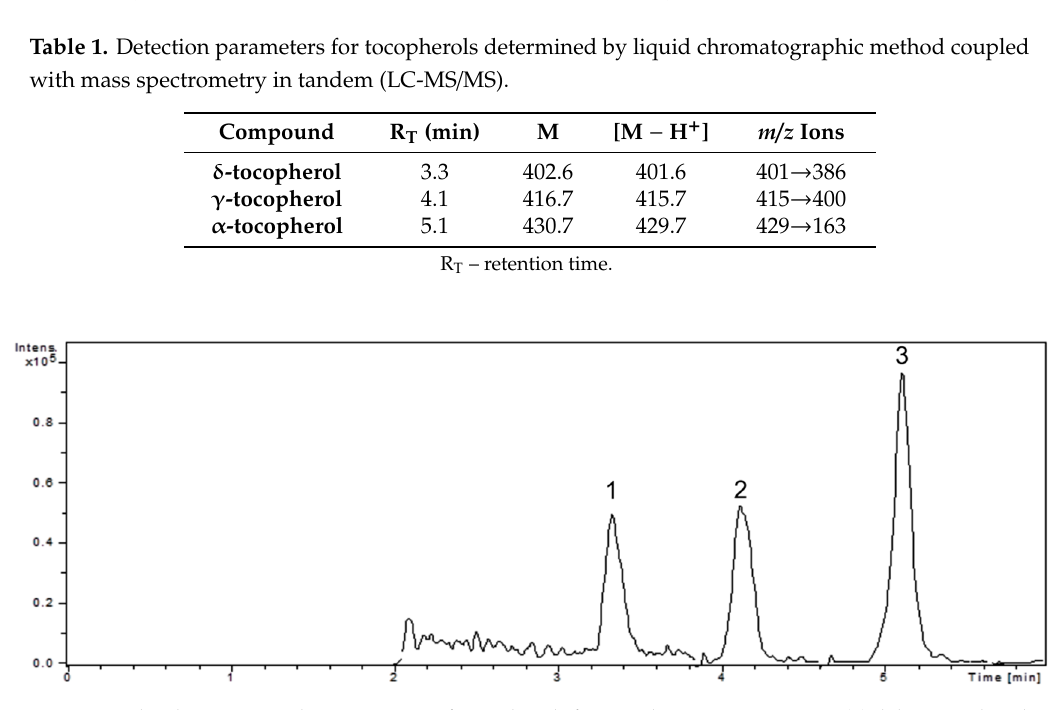
Figure 1. The chromatographic separation of tocopherols from walnut septum extract: (1) delta-tocopherol; (2) gamma-tocopherol; (3) alpha-tocopherol.